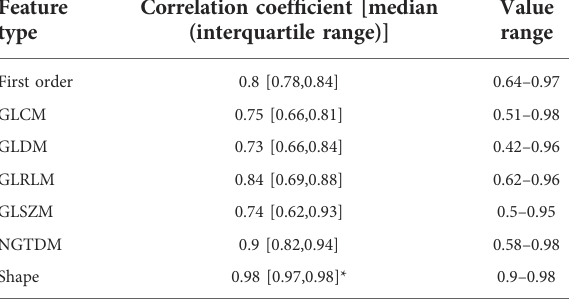
TABLE 2 Correlation of various features in unenhanced and enhanced